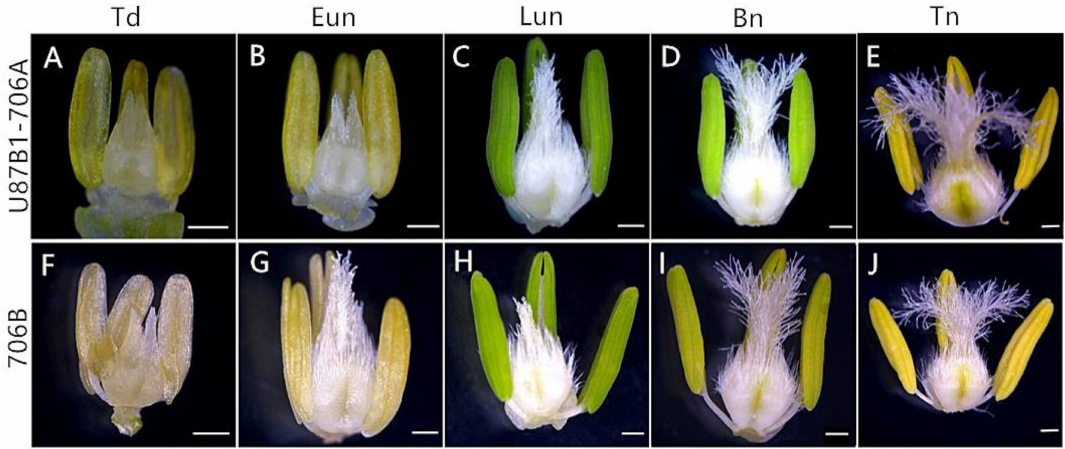
Figure 1. Comparisons of the anther phenotype in U87B1-706A ( A – E ) and 706B ( F – J ). ( A , F ) Td, tetrad stage; ( B , G ) Eun, early uninucleate stage; ( C , H ) Lun, late uninucleate stage; ( D , I ) Bn, binucleate stage; and ( E , J ) Tn, trinucleate stage. Scale bars are 500 µ m in ( A – J